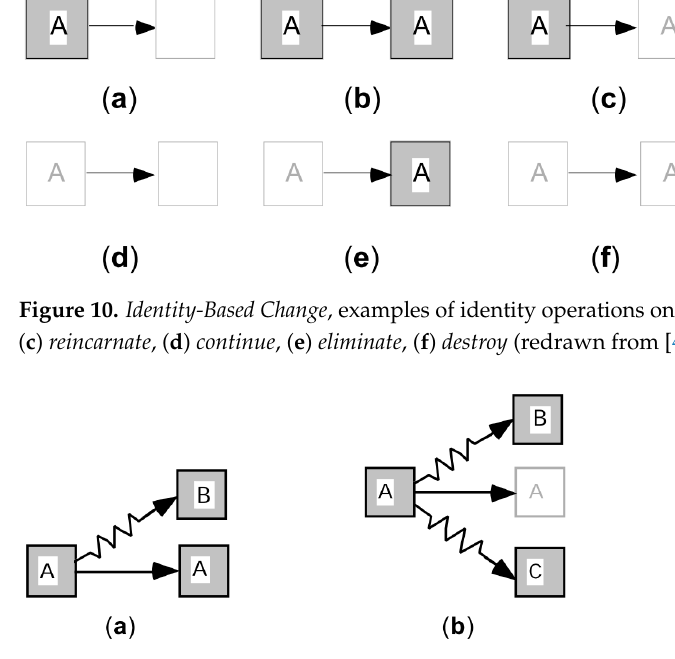
Figure 11. Identity-Based Change , examples of splitting objects: ( a ) splinter and ( b ) divide (from [90] ).